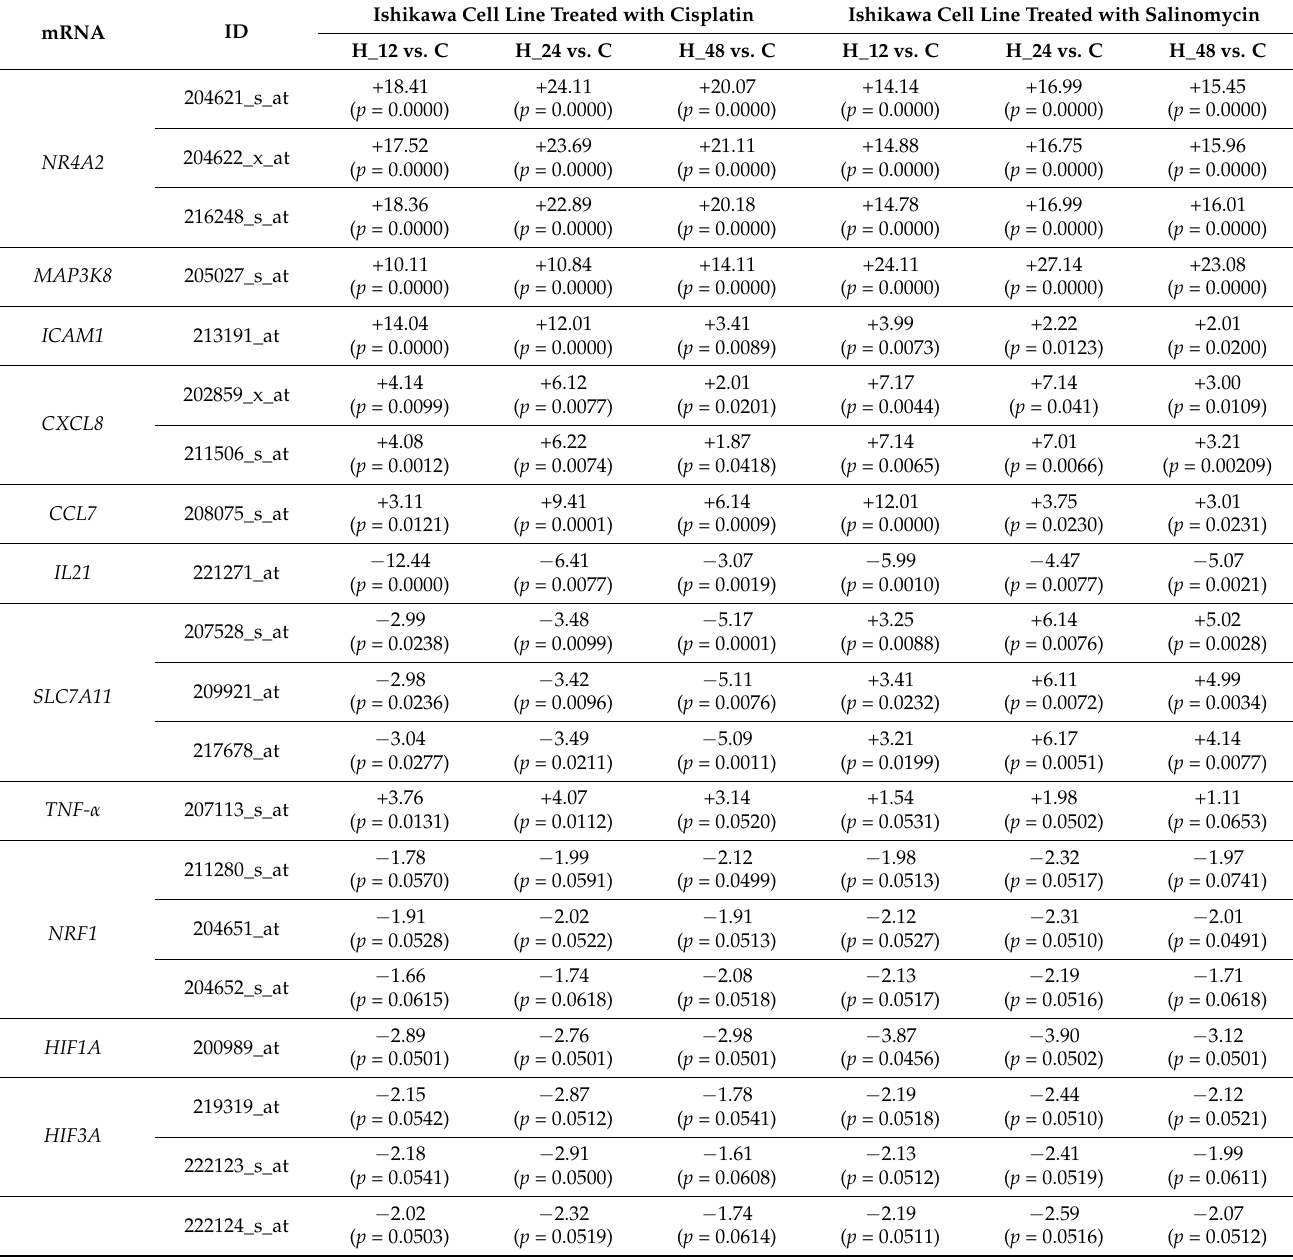
Table 2. Expression profiles of genes differentiating the Ishikawa cell line, regardless of the time of incubation with either cisplatin or salinomycin, in comparison with the